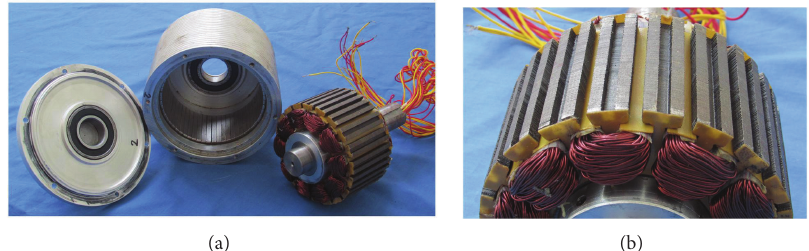
Figure 14: Prototype machine. (a) Stator and rotor assembly. (b) FMPs in stator.